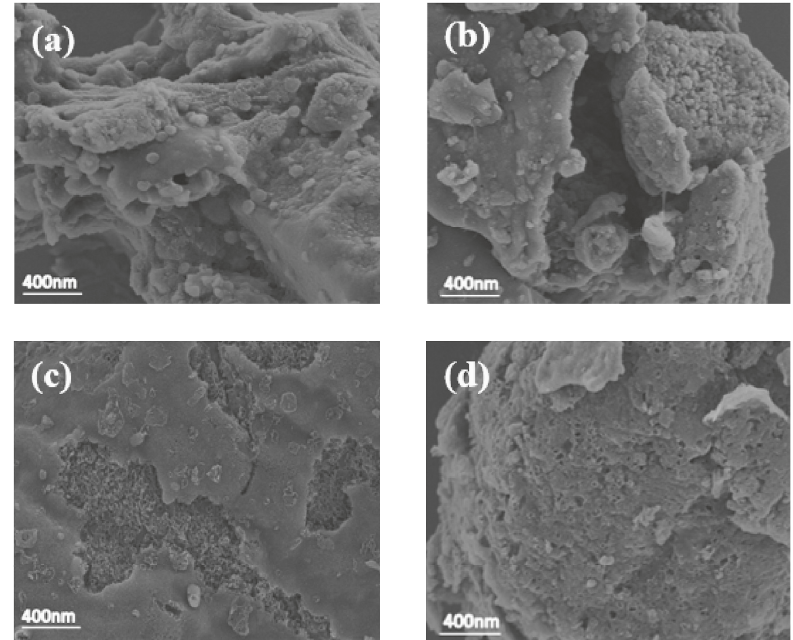
Figure 3: SEM of PRC-500 ° C (a) and PRC-600 ° C (b); SEM images of DPRC-500 ° C (c) and DPRC-600 ° C